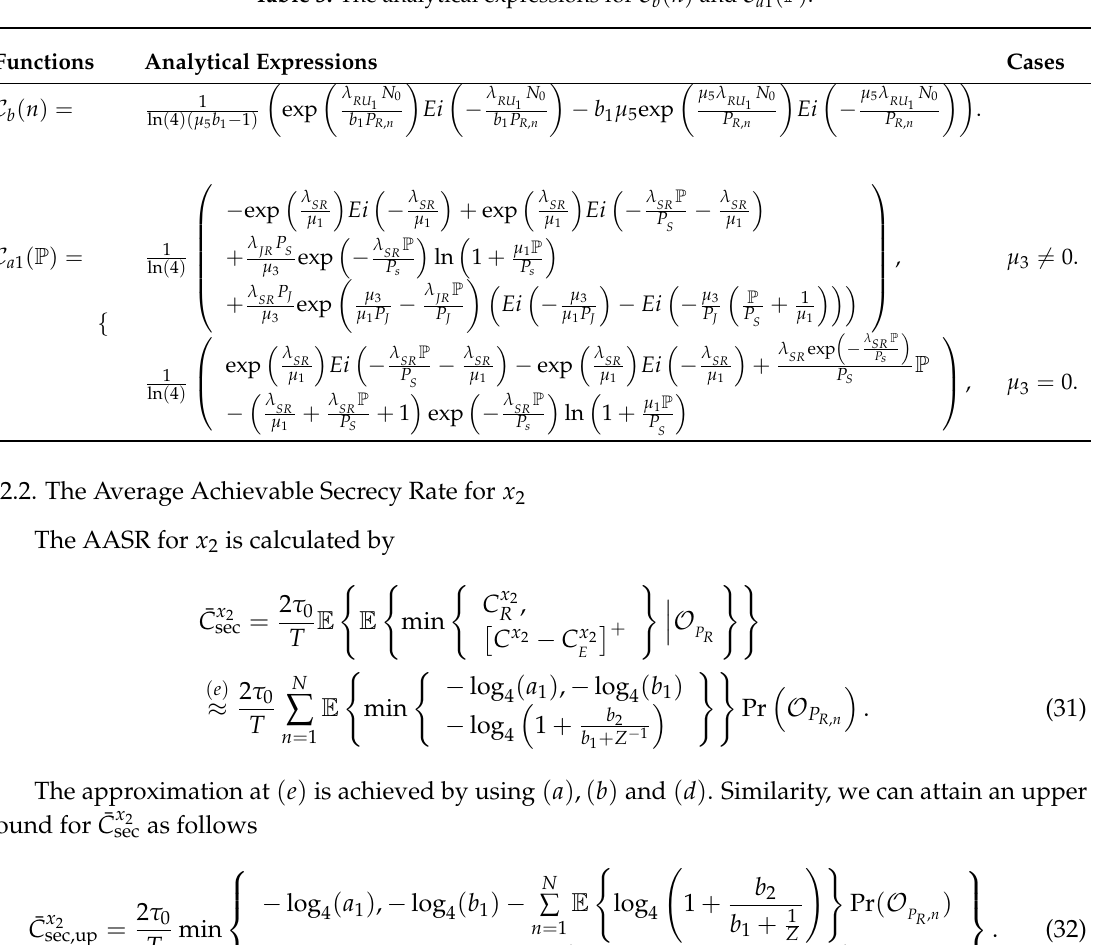
Table 3. The analytical expressions for C b ( n ) and C a 1 ( P )